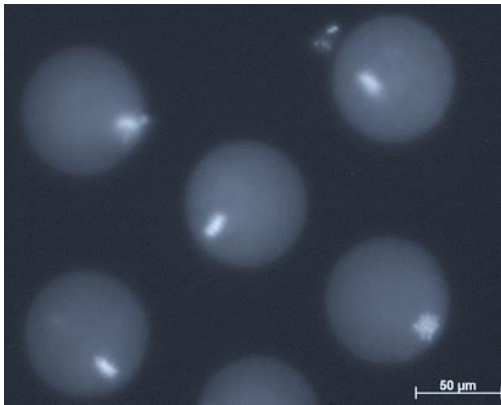
Figure 2. Fluorescent microscopy image of Hoechst 33342 DNA stained B6D2F1 mouse oocytes (image captured by C.G. as part of her Masters dissertation at the Reproductive Biology Laboratory, University of Pretoria).